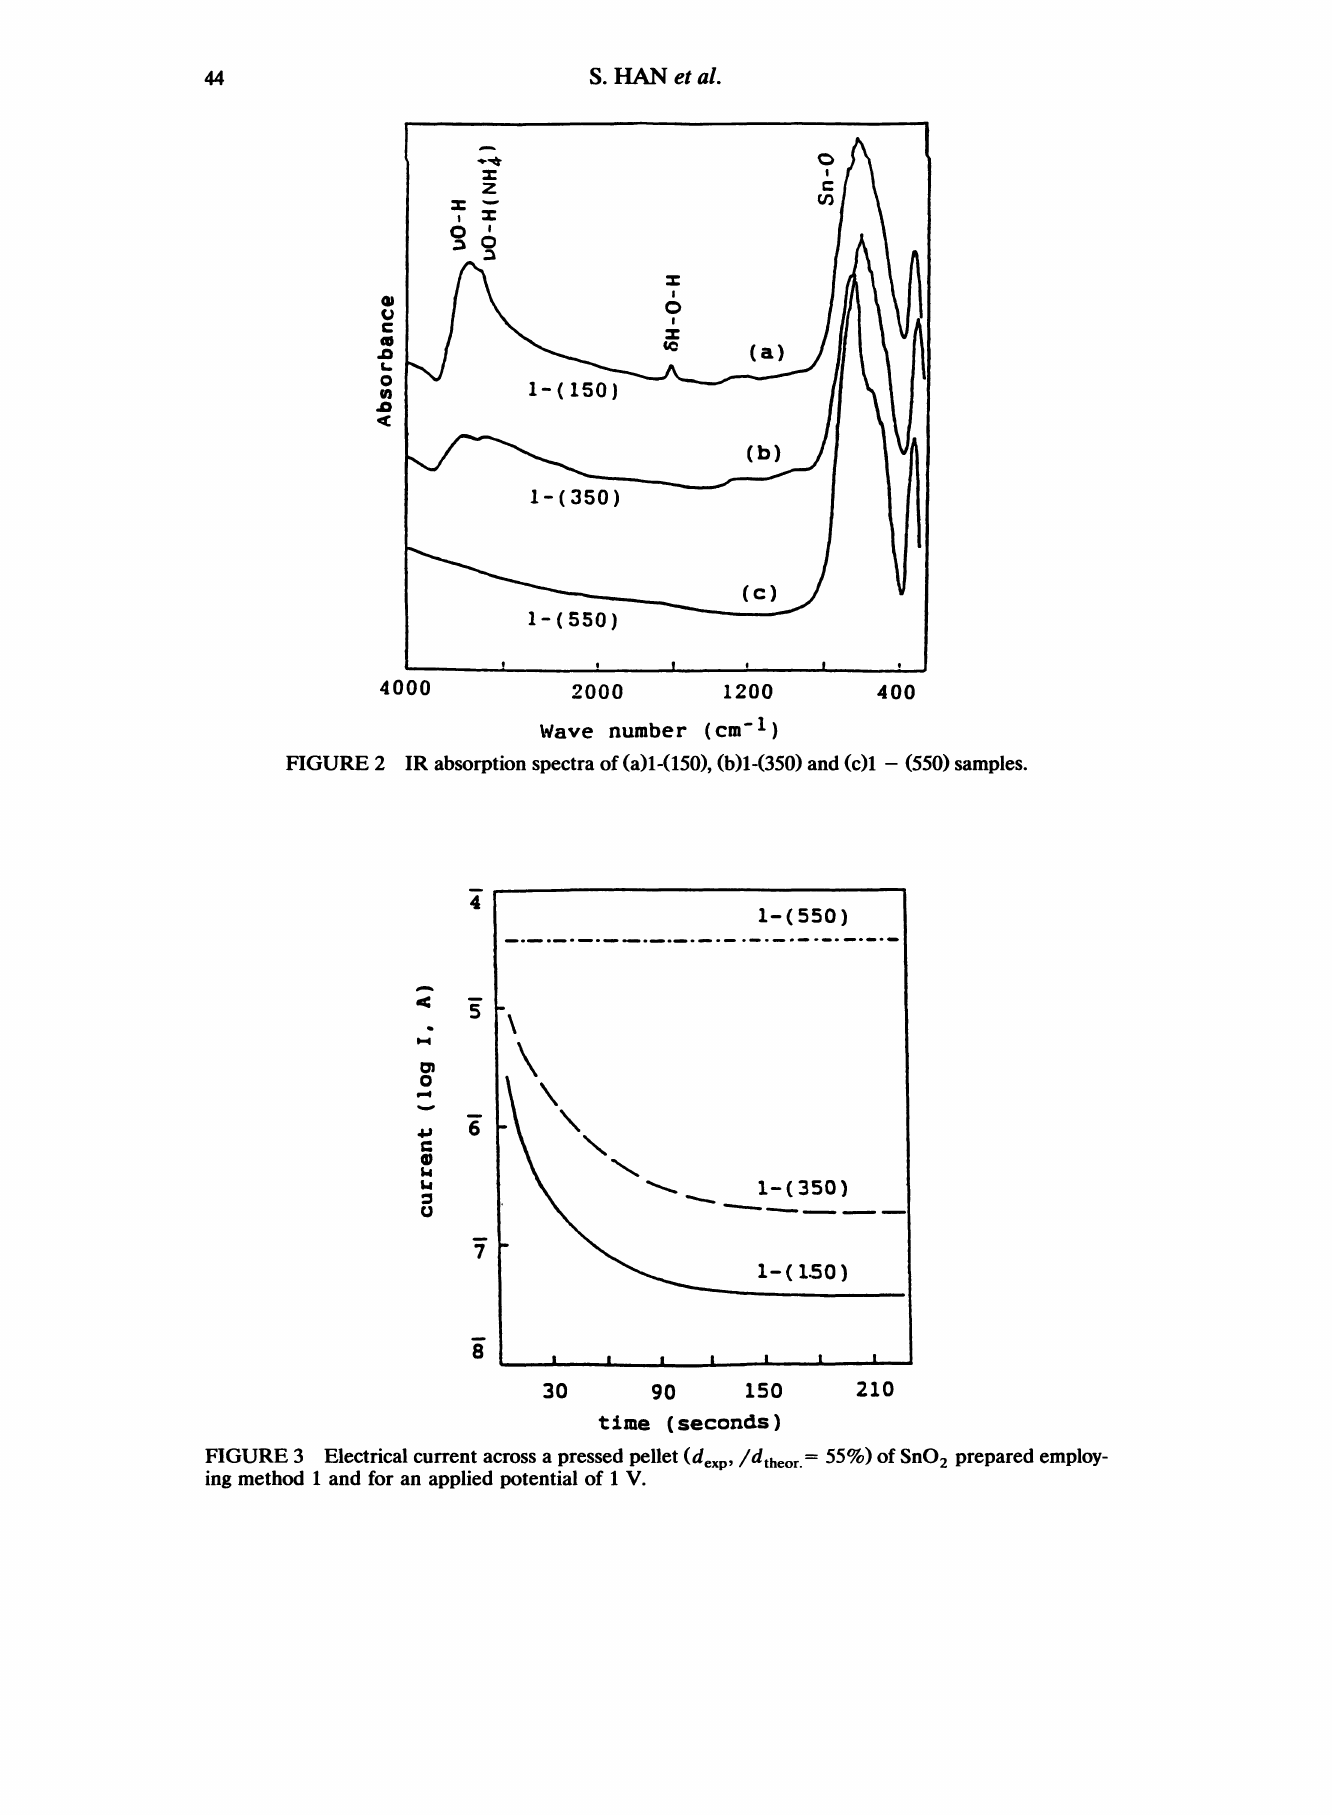
FIGURE 2 IR absorption spectra of (a)l-(150), (b)I-(350) and (c)l (550) samples.